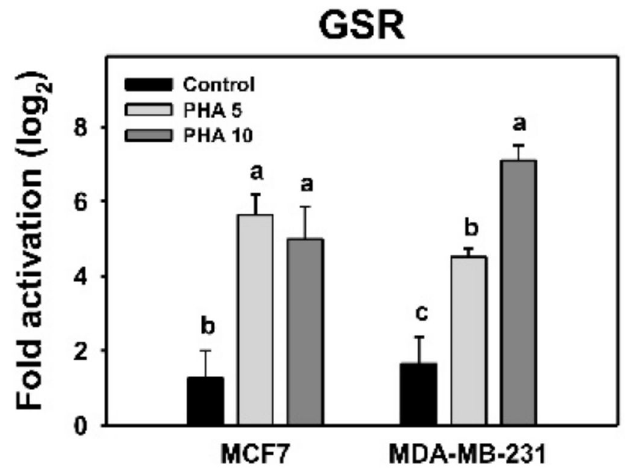
Figure 7. PHA induced GSR mRNA expression in breast cancer cells. Cells were incubated with PHA (0 (0.05% DMSO as control), 5 (PHA 5), and 10 (PHA 10) µ M) for 24 h. Data, means ± SDs ( n = 3 independent experiments). Experiments without the same top-labeled letters indicate significant changes according to multiple comparisons ( p < 0.005 to 0.0001).